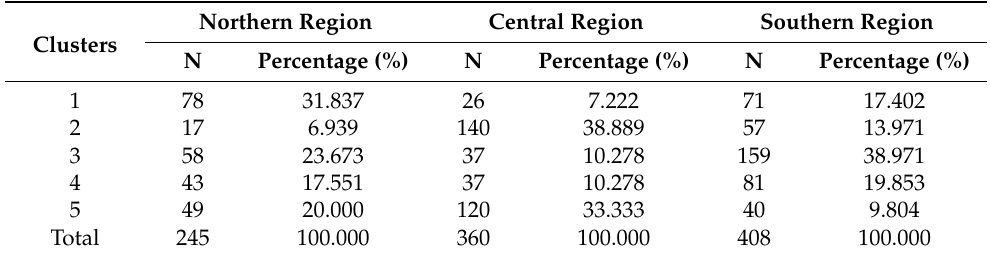
Table 4. Characteristics of farmer categories of different regions in Yuzhong county (N = 1013).